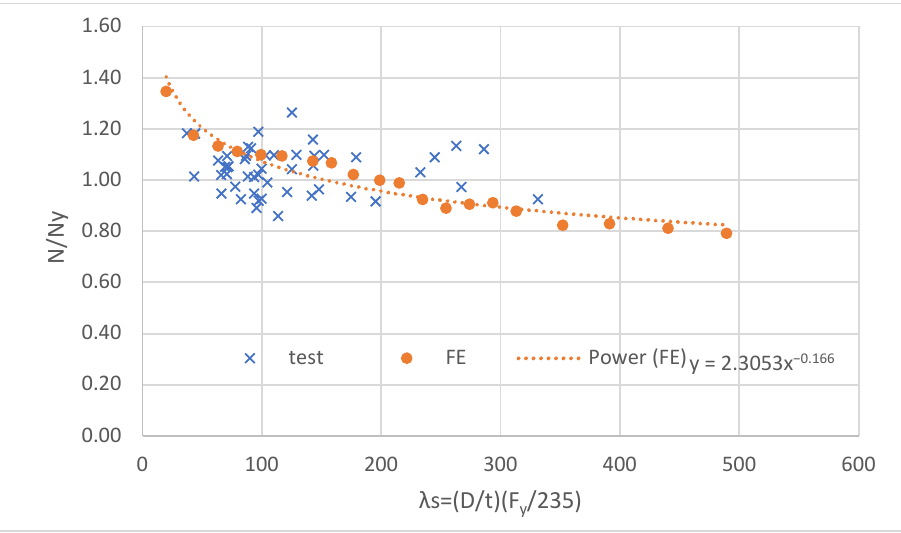
Figure 13. The relation between normalized axial compression and section slenderness of experimental results by others and FE by authors for HSS-S460.